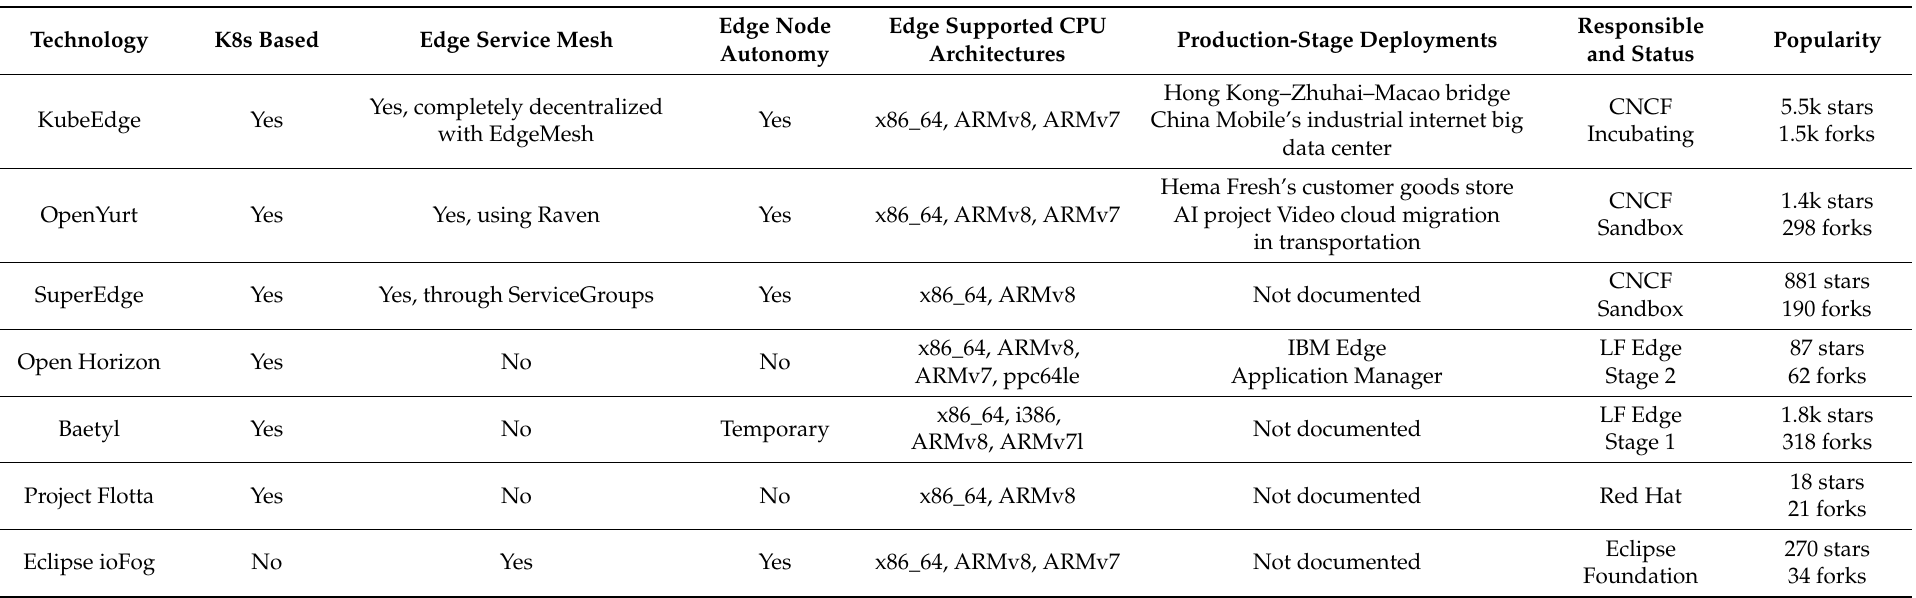
Table 1. Comparison of technologies for container orchestration at the